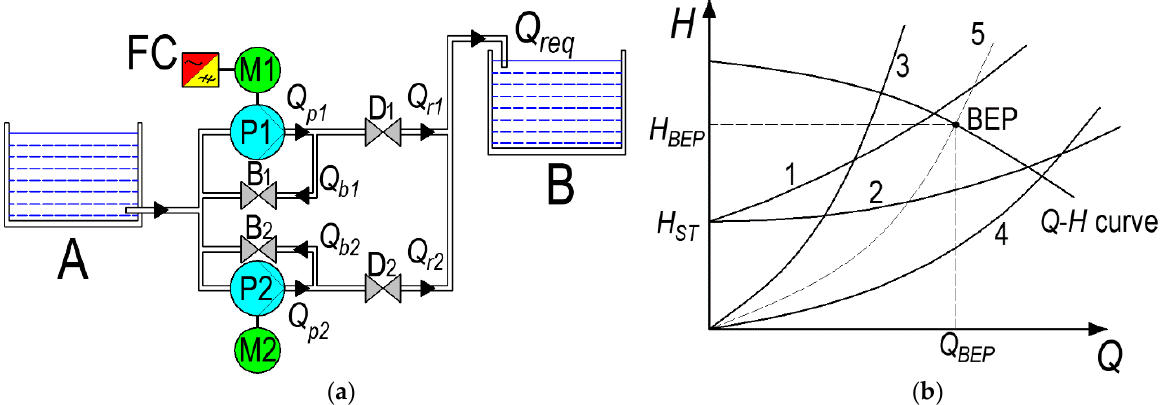
Figure 2. ( a ) Pumping system structure; ( b ) Q-H characteristic of the pump and the hydraulic system curves. Depending on the geometric dimensions of the pipelines (length, cross-section, shape, etc.), the physical properties of the pumped liquid (density, viscosity, etc.), and the